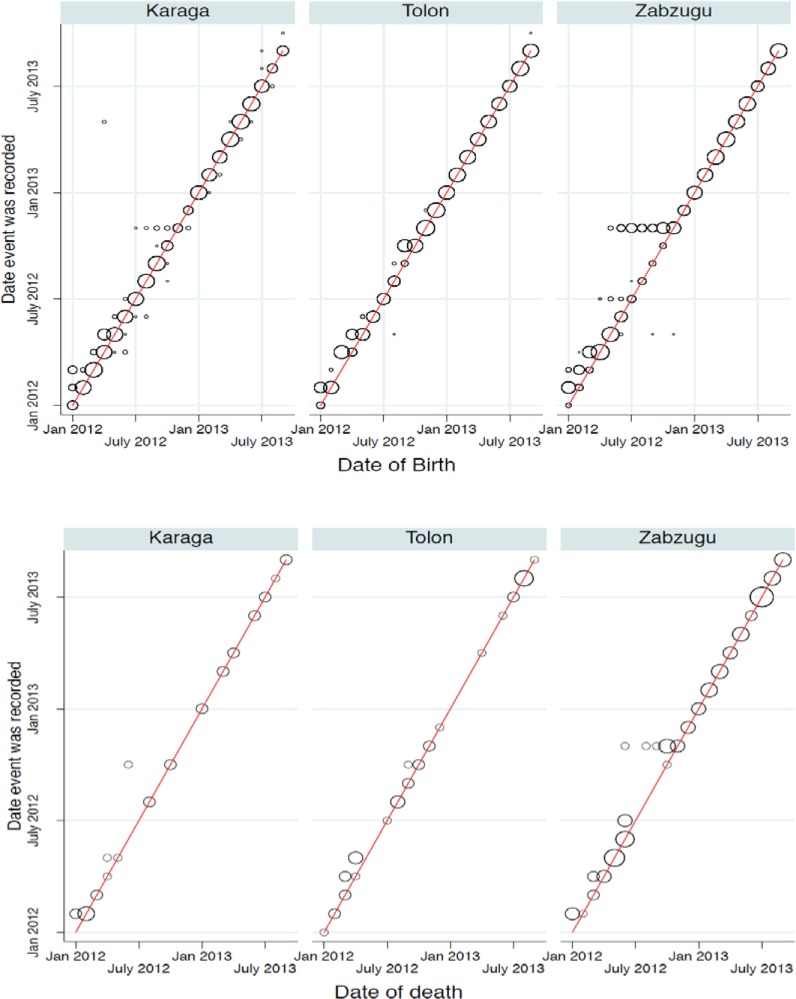
Reporting delays in CBV data.Panel a: delays in reporting of births. Panel b: delays in reporting of deaths, by district.
Notes: each circle represents the number of events having occurred during month x and being recorded during month y. The size of each circle is proportional to the number of such events. The red line represents the absence of reporting delays, i.e., x = y. Circles above the red line represent events reported with delays, whereas circles below the red line represent events that were reported before they occurred (i.e., possible data entry errors).